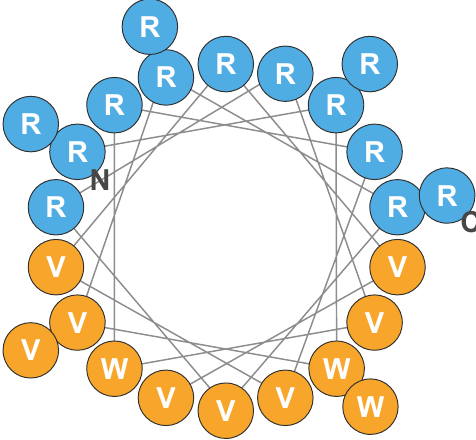
Figure 1. Helical wheel of the predicted structure of PLG0206. Blue circles indicate hydrophilic (cationic) amino acid residues; orange circles represent hydrophobic residues. C, carboxy terminus; N, amino terminus; R, arginine; V, valine; W, tryptophan. Adapted from Deslouches et al., 2005, 2015, and 2020 [9–11] .